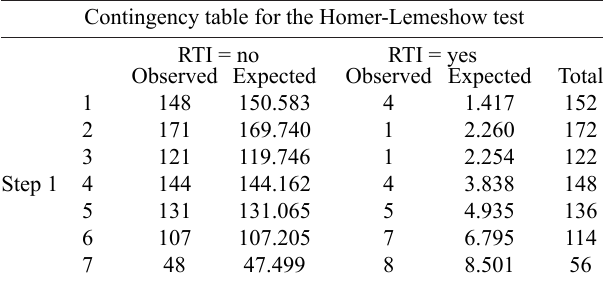
Table 3. RTI observed and predicted using EuroSCORE as predicting variable in the groups defined according to the Hosmer- Lemeshow test.